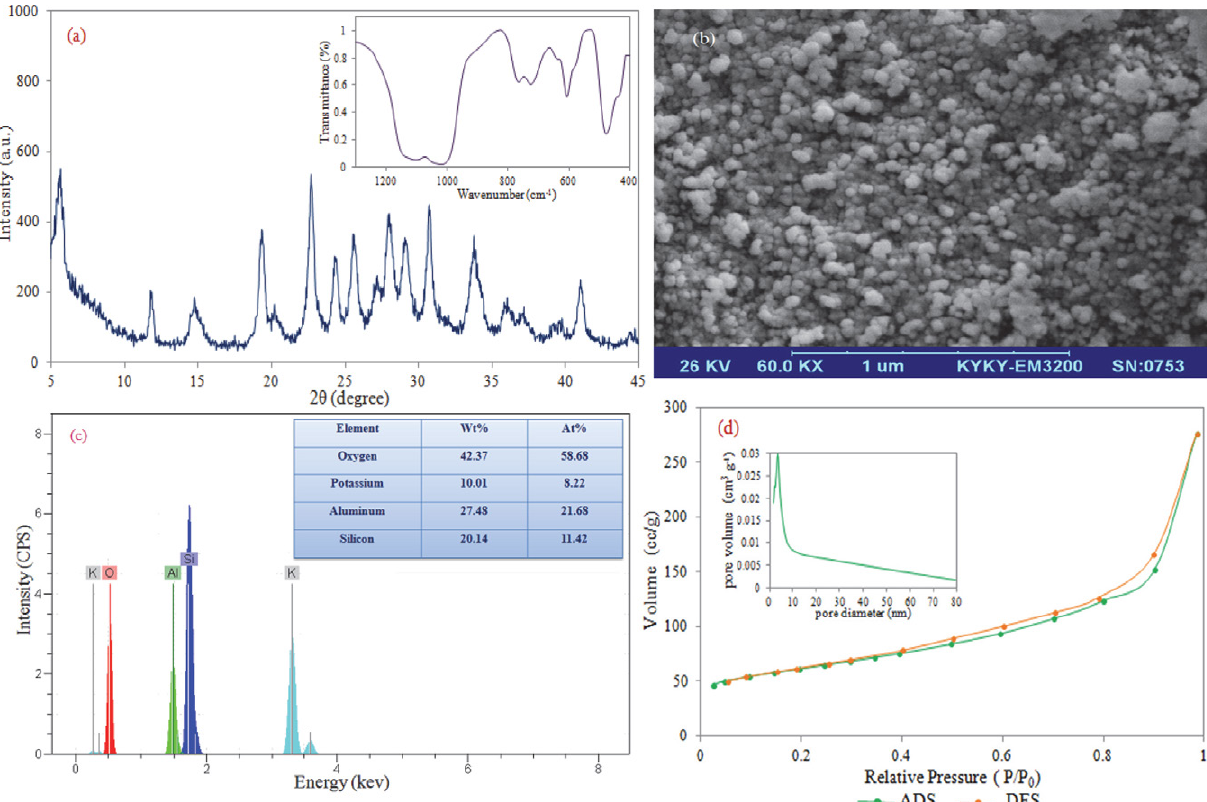
Figure 1. (a) XRD pattern of synthesized nanozeolite L, Inset: FT‐IR spectrum of nanozeolite L, (b) SEM image of nanoparticles of zeolite L, (c) EDX spectrum of nanozeolite L, (d) Nitrogen adsorption-desorption isotherms of nanozeolite L, Inset: pore size distribution of nanozeolite L